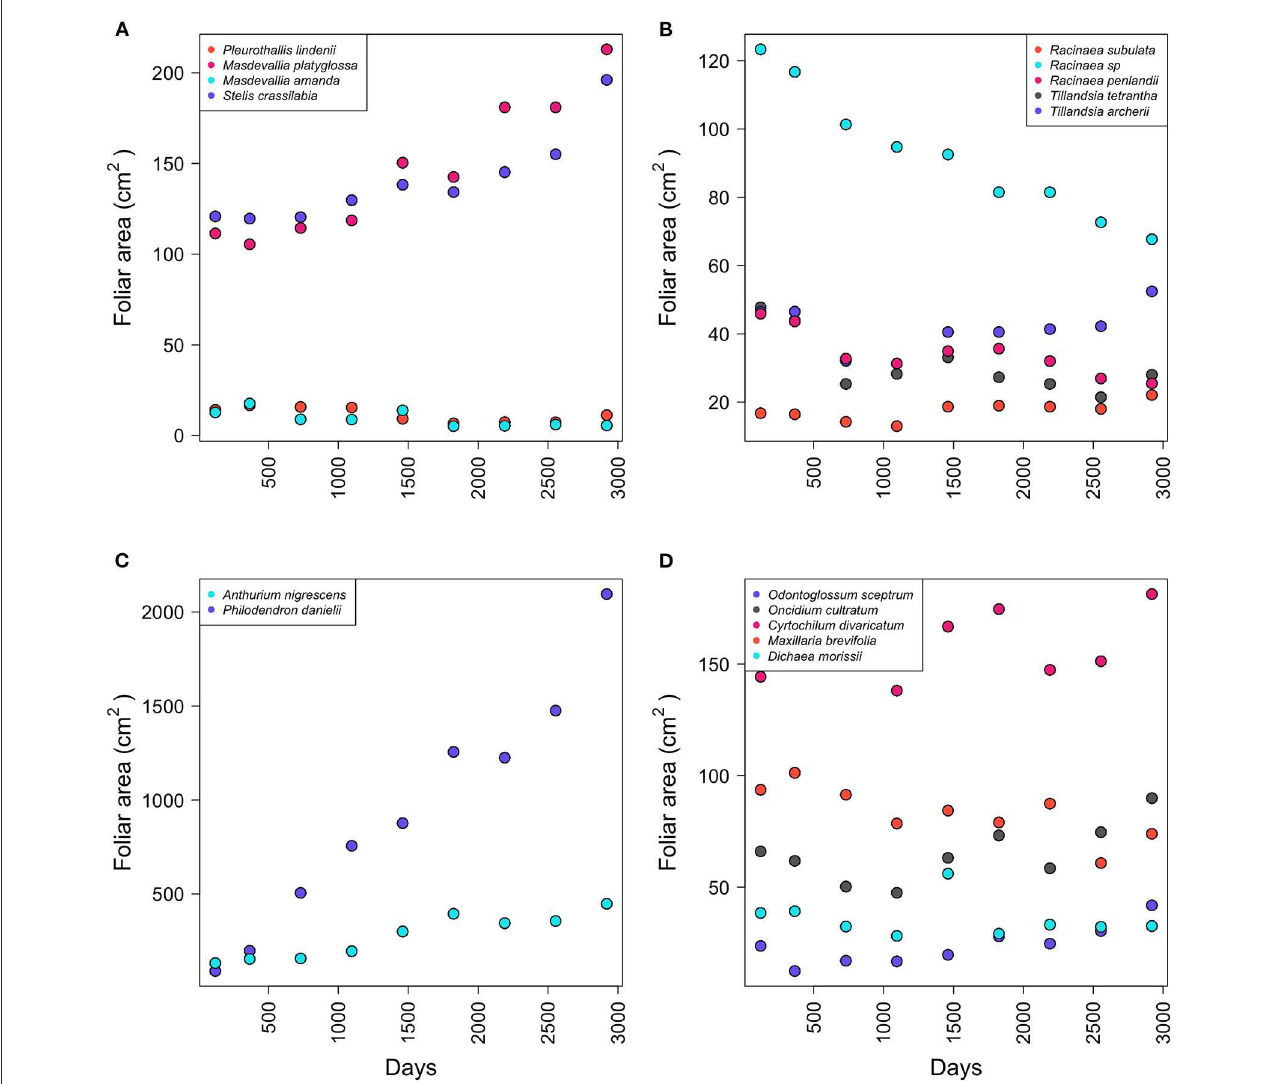
FIGURE1 Total leaf area by species according to functional group. Epiphytic species correspond to the following functional groups (FG): (A) FG3, (B) FG4, (C) FG6, and (D)